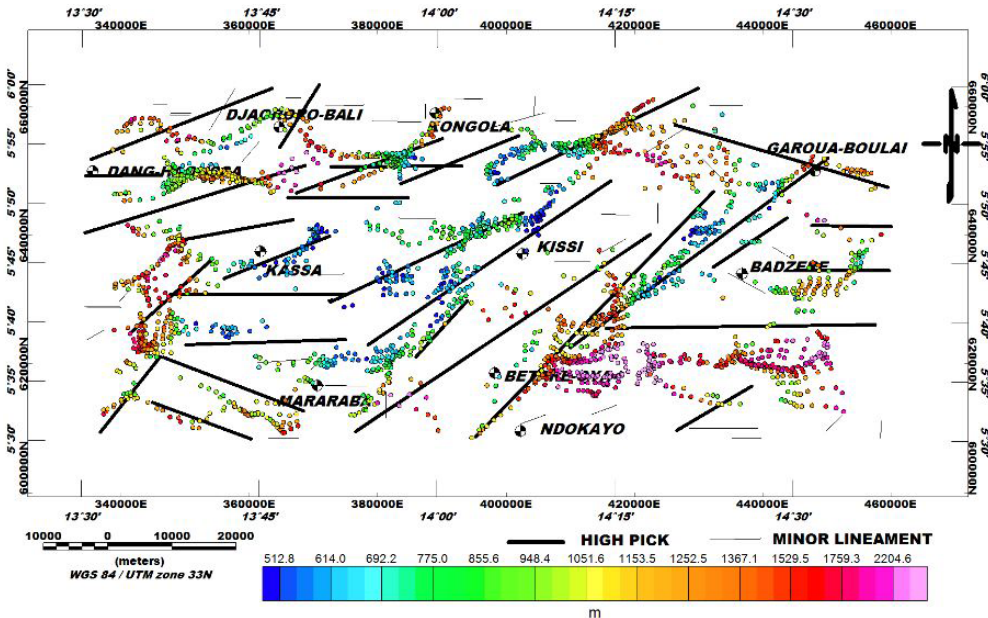
Figure 9. Euler solution ( N = 1; W = 25; Z =